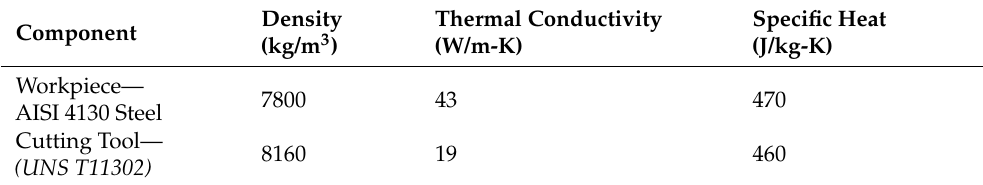
Table 5. Thermal properties of cutting tool and workpiece.